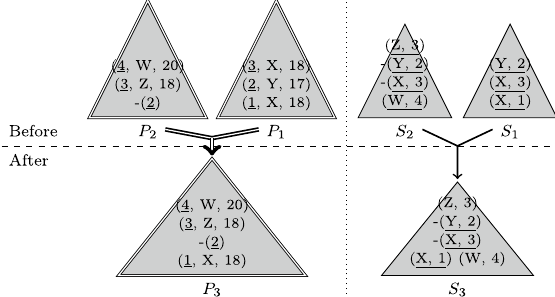
Fig. 2 LSM merge operation. Primary index and secondary index are merged independently. Anti-matter records (marked with -) can be completely deleted if the oldest disk component (e.g. P 1 or S 1 ) is involved in the